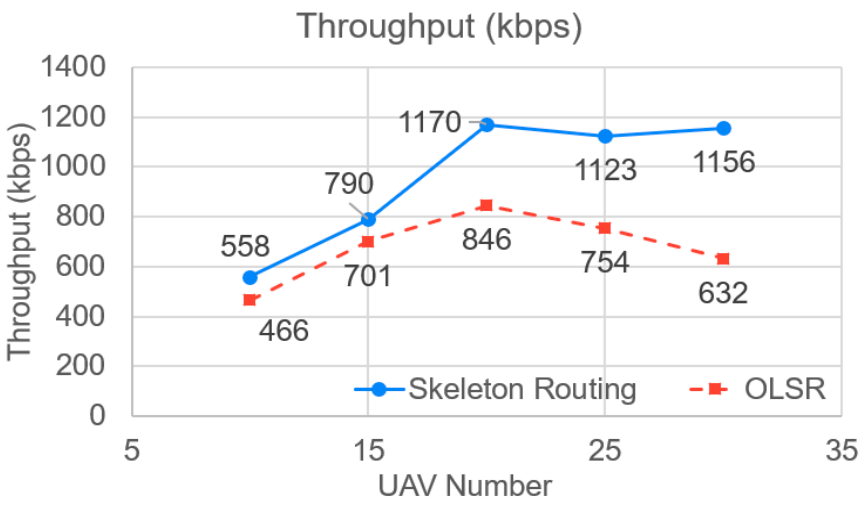
Figure 19. Throughput results with varying network sizes.